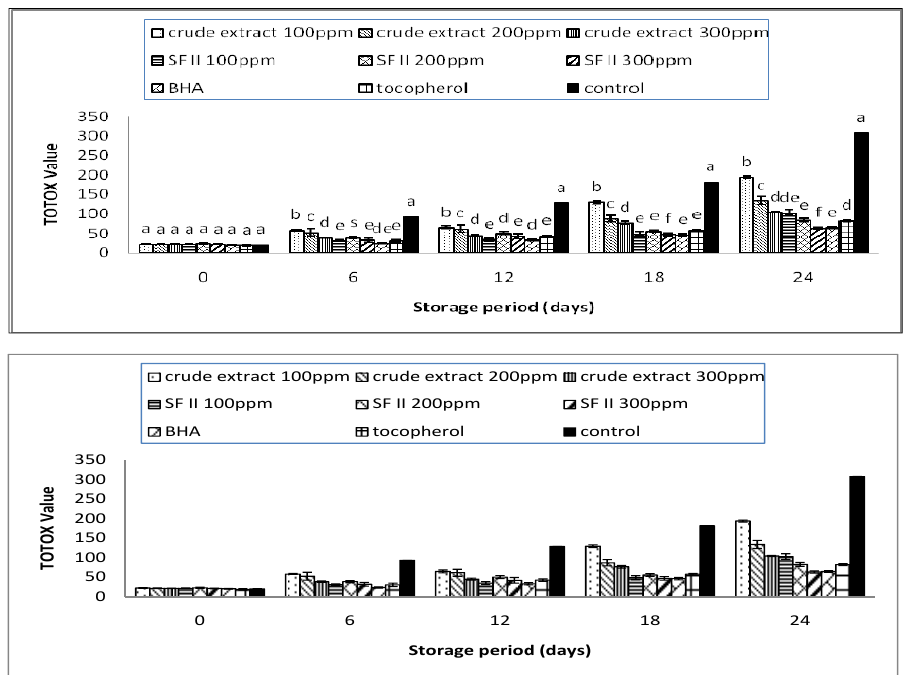
Figure 3. The TOTOX value of the supplemented sunflower oil with rambutan extracts, BHA and tocopherol under accelerated storage at 65 °C for 24